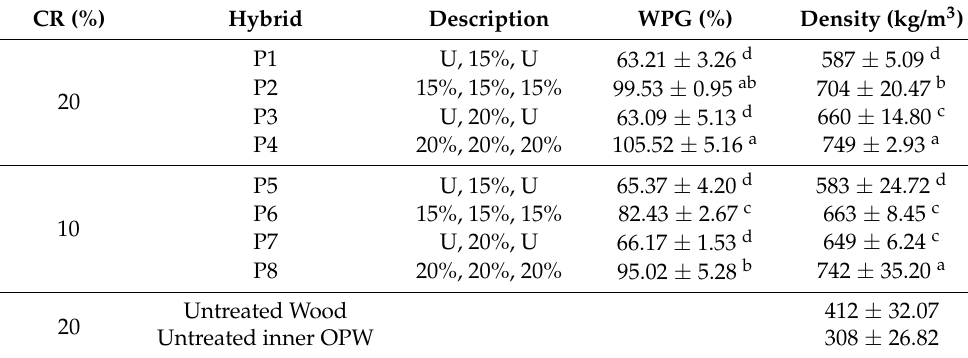
Table 4. Mean values of WPG and density of laminated compreg composites.